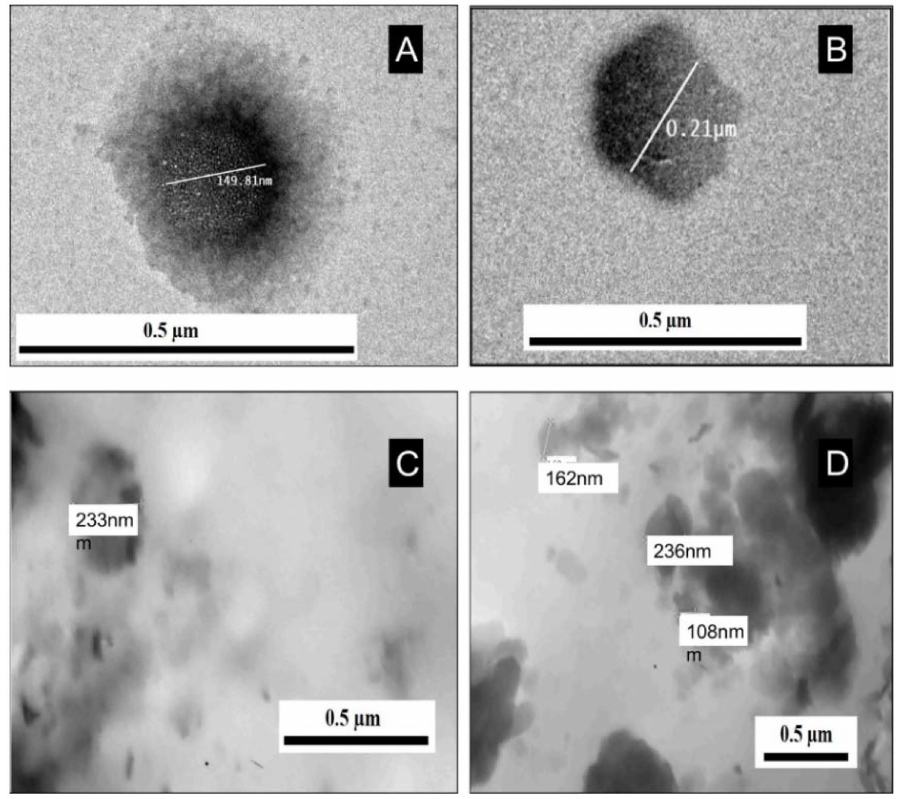
Figure 1. The TEM images of the exosomes isolated from ( A ) MCF 7, ( B ) MCF 7/ADR, ( C ) SH-5YSY, and ( D )